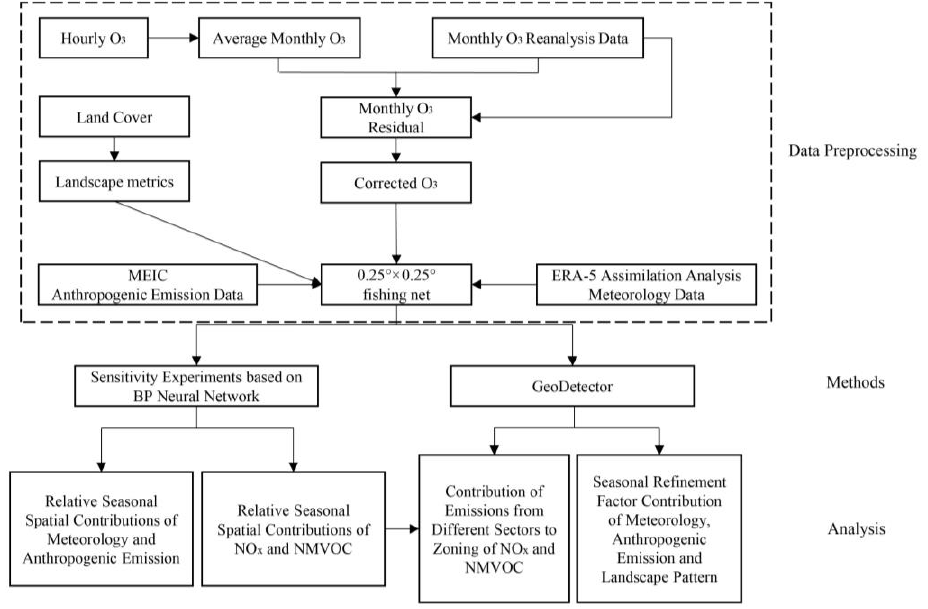
Figure 3. Research